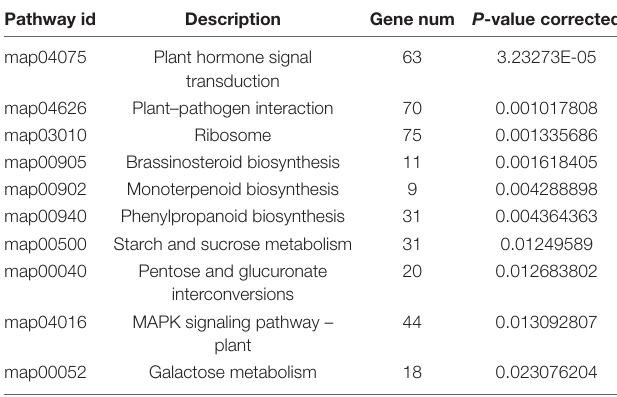
TABLE 1 | The metabolic pathways involved in response to drought stress in Mesona Chinensis Benth